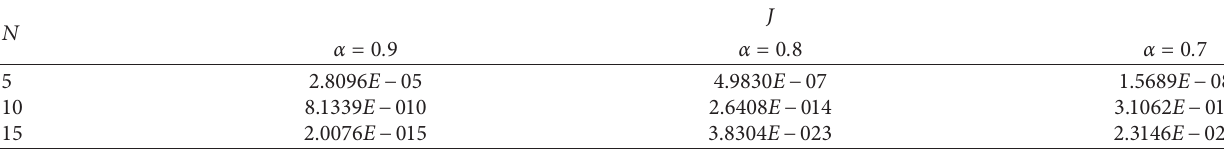
Table 3: Different values of J in Example 3.